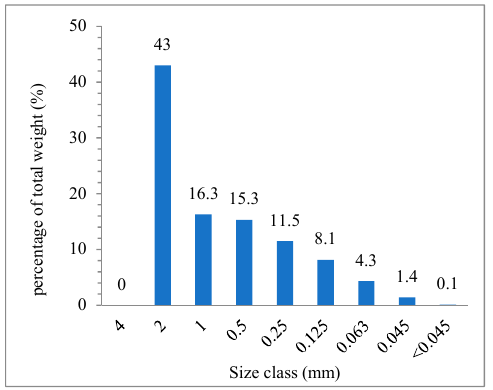
Figure 2. Percentage of shred weight on screens with decreasing mesh size.